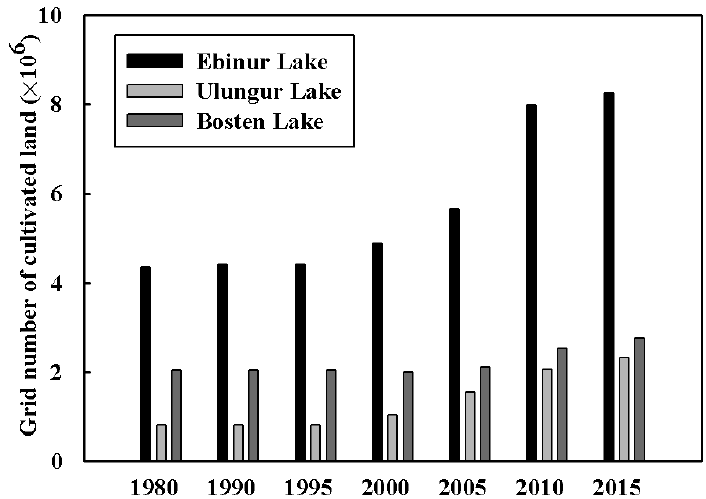
Figure 7. The raster number of cultivated land from 1980 to 2015.